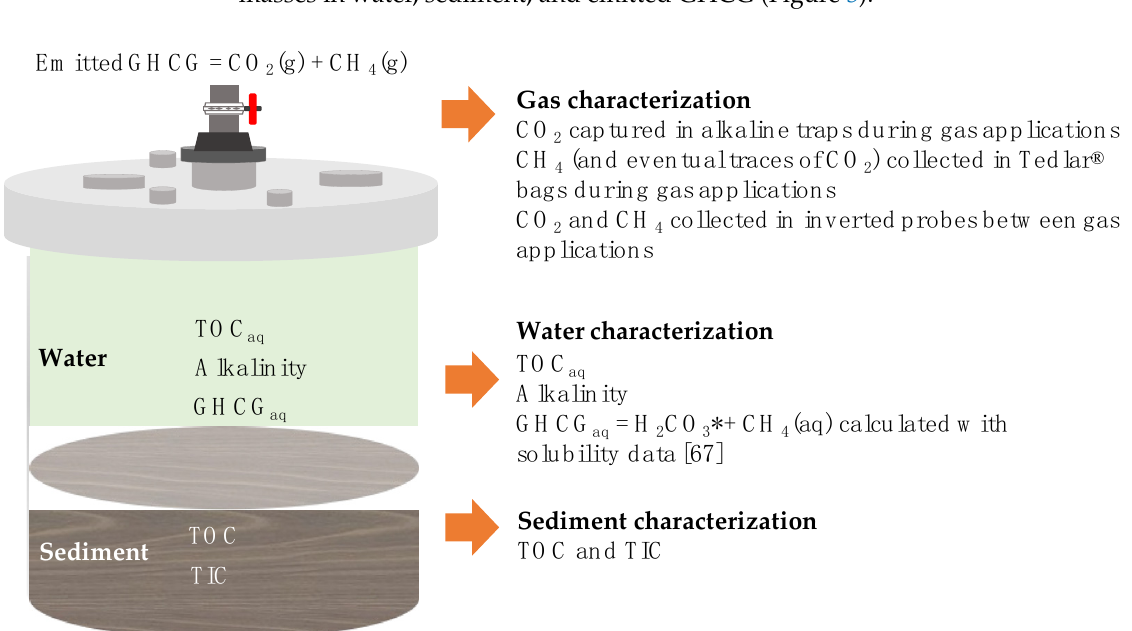
Figure 3. Carbon mass-balance for the experimental reactors. GHCG(aq) = H 2 CO 3 * + CH 4 (aq) calculated with solubility data[67].